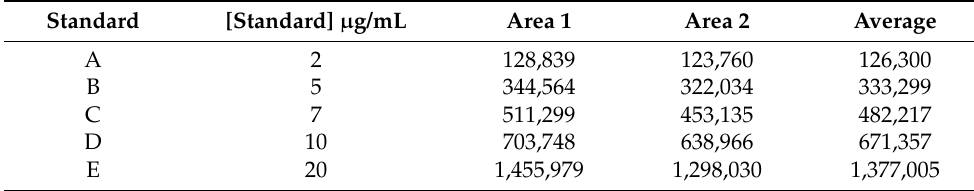
Table 5. Peak Areas obtained from the